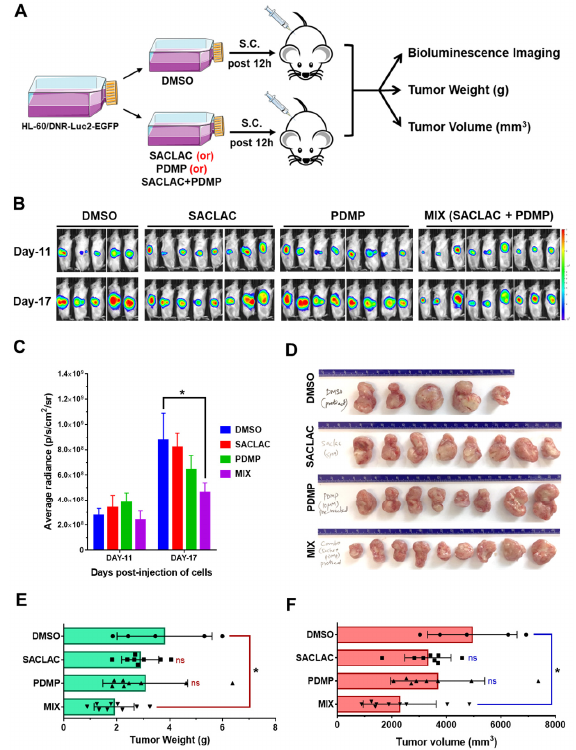
Figure 6. Exposure of HL-60/DNR cells to combination SACLAC D- threo -PDMP ameliorated tumor progression in vivo. ( A ) HL-60/DNR-Luc2-EGFP cells were treated in vitro with either SACLAC (5 µM), D- threo -PDMP (10 µM), or the mix for 12 h; controls were treated with vehicle (DMSO). An equal number of viable cells (2.5 × 10 6 ) from control and treatment groups (cell viability did not di ff er after 12 h pretreatment) were injected subcutaneously (s.c.) into 7–9 wk old male NRG-S mice (5–9 animals/group), and tumor progression was monitored by bioluminescence imaging (BLI), measurement of tumor weight (gm), and tumor volume (mm 3 ). ( B ) BLI Images of mice on indicated days post-injection of pretreated HL-60/DNR-Luc2-EGFP cells injected s.c. ( C ) Quanti fi cation of BLI signals as average radiance (p/s/cm 2 /sr) for di ff erent treatment groups on indicated days. * p < 0.05 denotes statistical signi fi cance compared to the DMSO group by two-way ANOVA (Dunne tt ’s mul- tiple comparisons test). ( D ), The tumors were harvested from di ff erent treatment groups for gross examination of tumor sizes. ( E , F ) Average tumor weight and tumor volume in di ff erent experi- mental groups were compared for statistical di ff erences by one-way ANOVA (Tukey’s multiple comparisons test) * p < 0.05 was considered signi fi cant compared to the vehicle DMSO group. To test e ffi cacy in patient-derived AML cells, a subset of patients was evaluated with SACLAC, D- threo -PDMP, or the combination. Approximately 70% demonstrated in- creased e ffi cacy with the combination over single agents. The patient cell viability data presented represent the top 9 samples showing the most potent combined drug e ff ects over single agents (Figure 7). As shown, the combination bene fi t from the enzyme inhibi- tor mix is readily evident in AML patient samples.